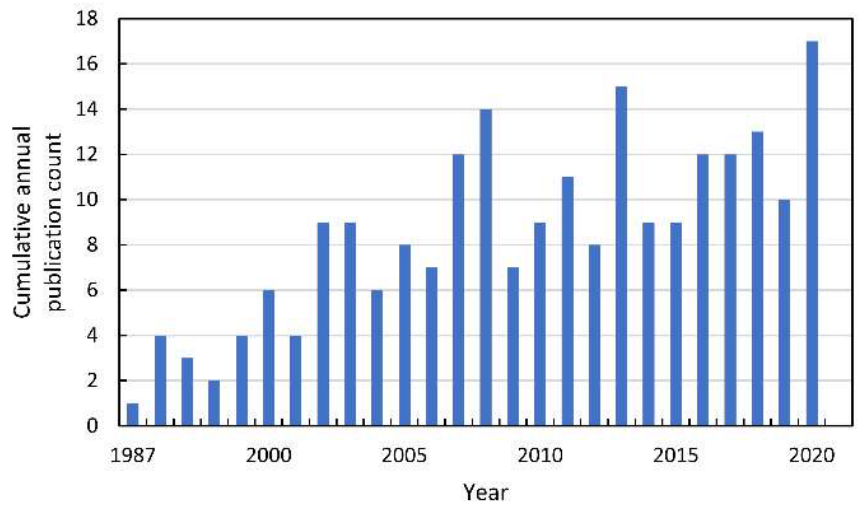
Figure 4. The cumulative annual publication count of papers on the mode of action of allelochemicals. Details of the search are described in Supplementary Materials.